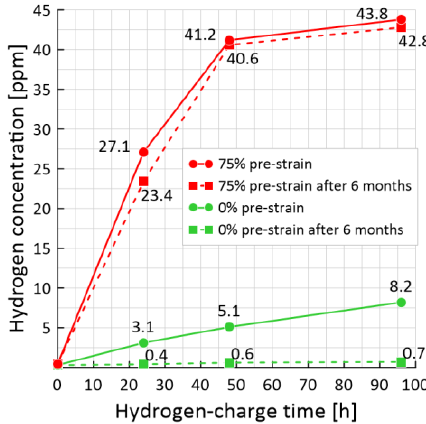
Figure 7. The effect of hydrogen-charged time on the hydrogen concentration measured immediately after the experiment (solid curves) and after 6 months of sample storage (dashed curves): red curves — with 75% pre-strain, green — with 0% pre-strain.